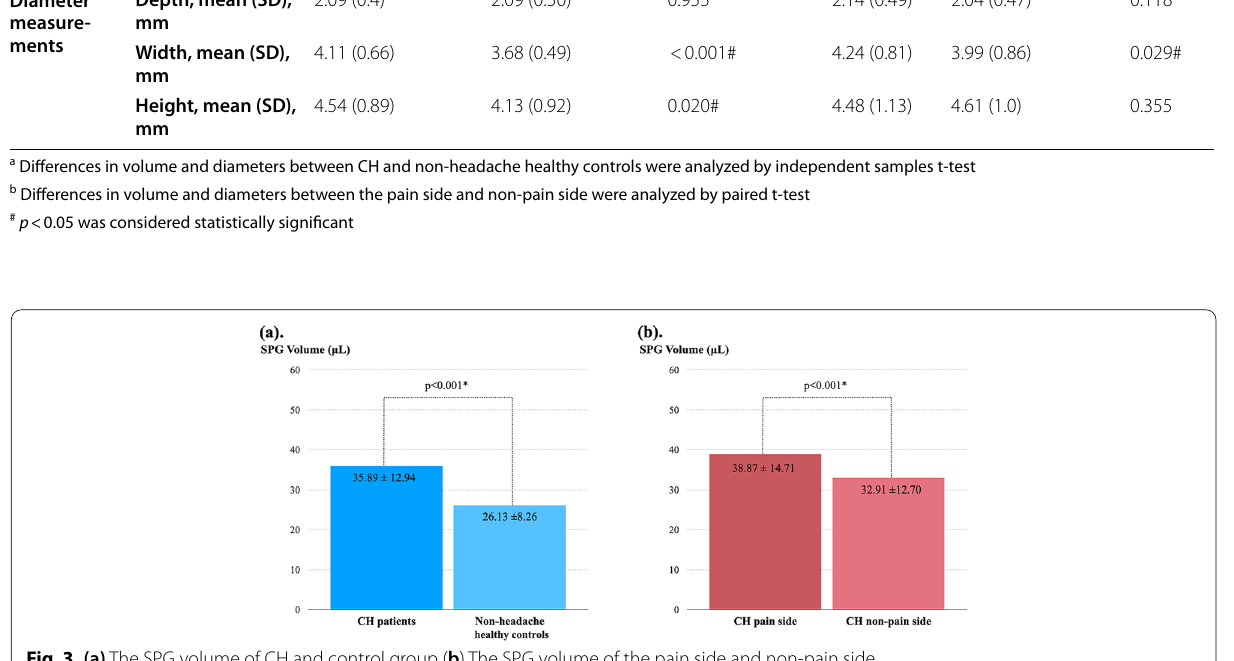
Table 3 Comparisons of SPG shapes (CH patients vs. non‑headache healthy controls and pain side vs. non‑pain side) SPG volume and